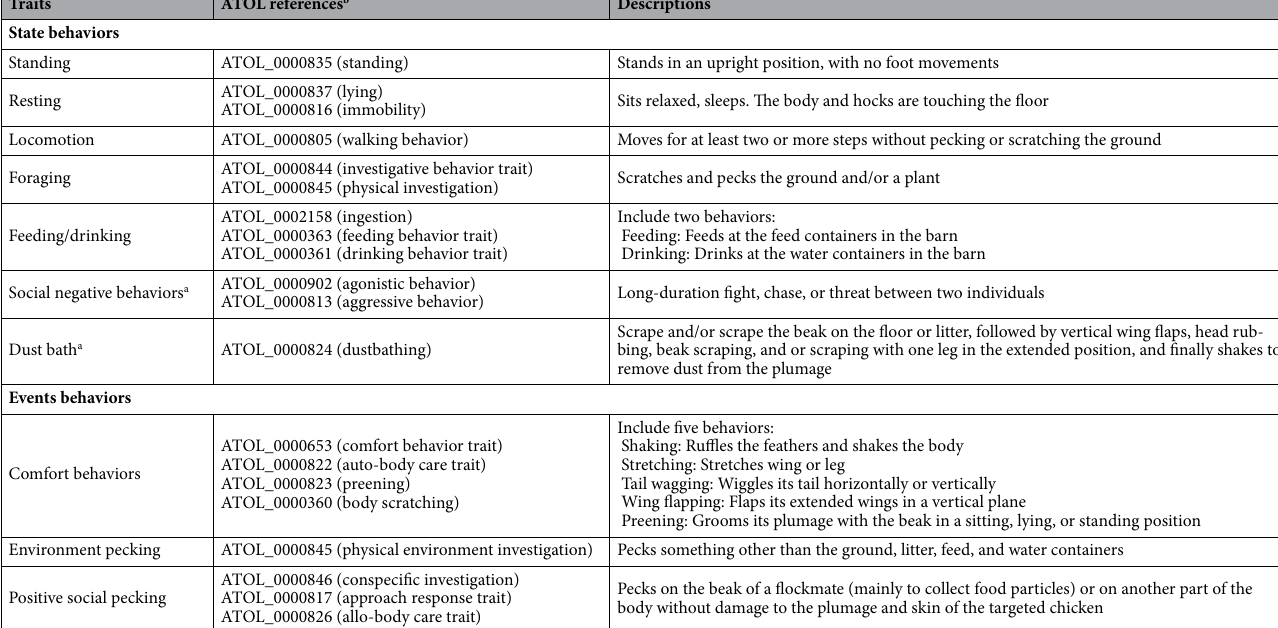
Table 1. Ethogram of recorded behaviors. a These behaviors were rare (less than 5% of the observed individuals expressed the behavior) and were discarded from statistical analyses. b Traits in reference to the ontology ATOL: https:// www. atol- ontol ogy. com/ en/